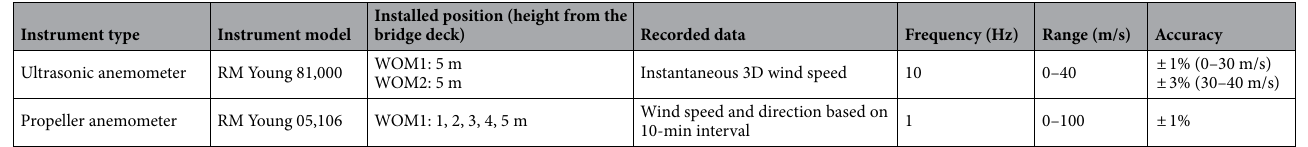
Table 1. List of the anemometer information.